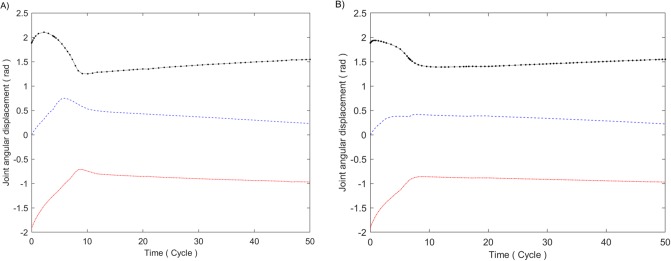
Results of introducing joint limit position constraints.(A) Image moment method. (B) Potential field method. Where the trajectory of the waist is designated with a blue dotted line, the trajectory of the upper arm is designated with a red dash-dotted line, and the trajectory of the lower arm is designated with a black pecked line.